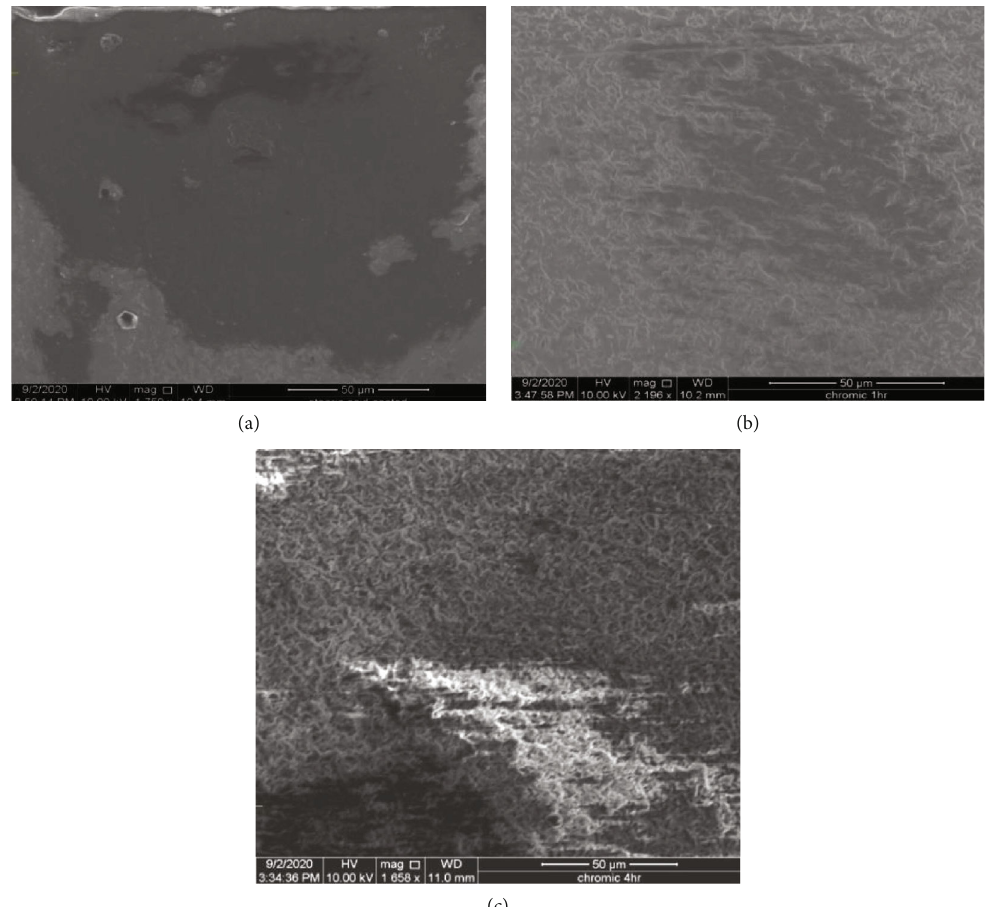
Figure 11: SEM images of a composite (a) before chromic acid etching and (b) after etching for 1h and (c) for